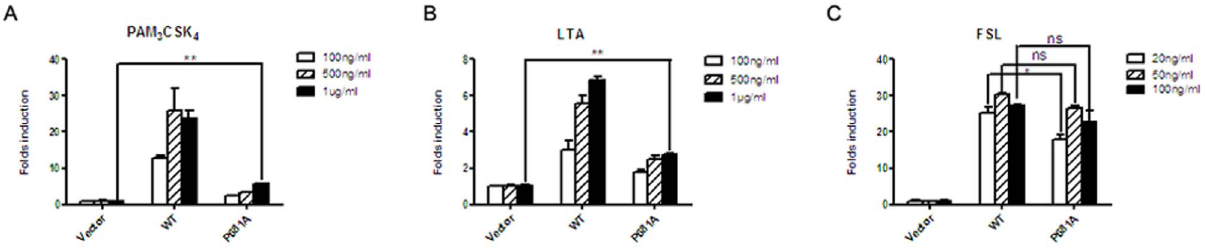
Figure 3. Responsiveness of human TLR2 (P681A) to TLR2/2, TLR2/1 and TLR2/6 agonists. HEK293T cells in 24-well plates were transfected with TLR2 (P681A), TK-RL and pBIIx-luc. At 24 h post-transfection, the cells were stimulated with the indicated concentrations of LTA (A), Pam3CSK4 (B) and FSL (C) for 6 h, respectively, and then both firefly and Renilla luciferase activities were determined using a dual-luciferase assay. The experiments were repeated for three times, and all of the data were expressed as the mean 6 SD. * P , 0.05, ** P , 0.01, ns, not